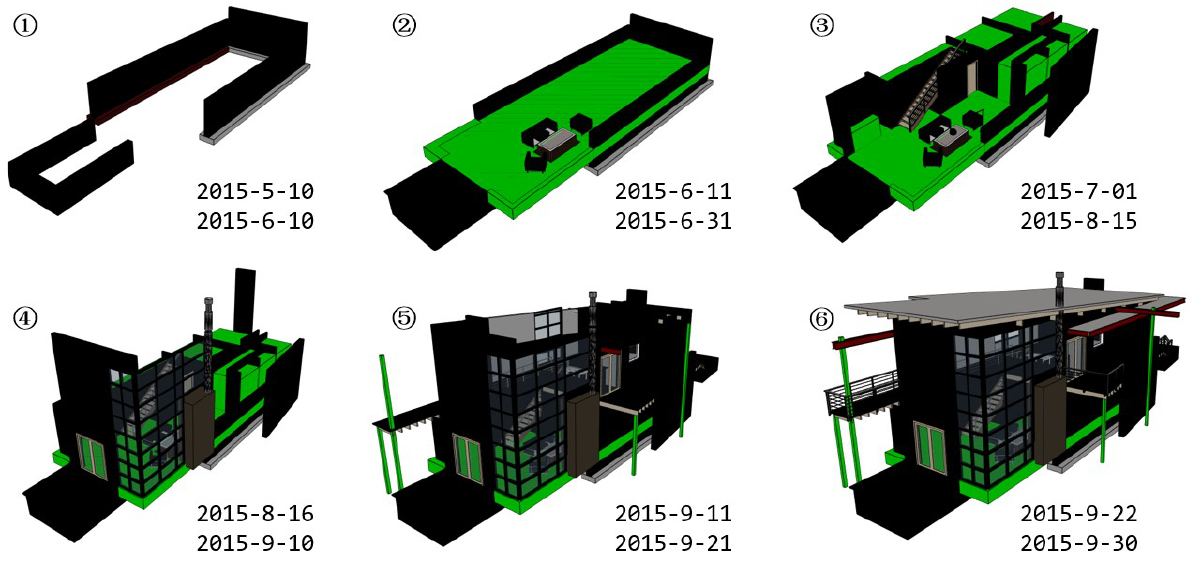
Figure 3. Construction process